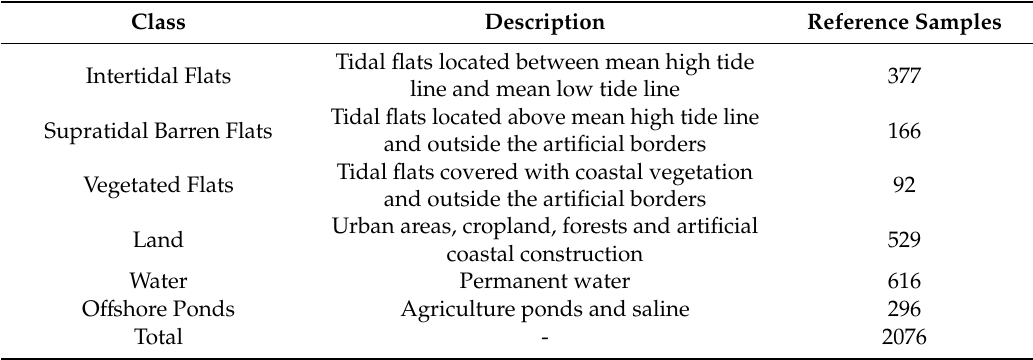
Reference Samples